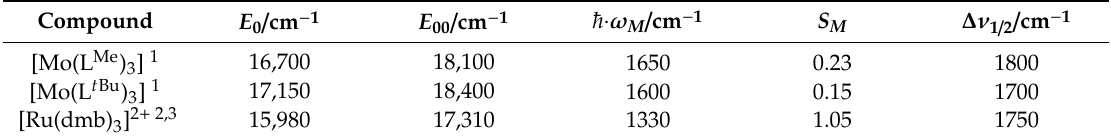
Table 3. Emission spectral fitting parameters.